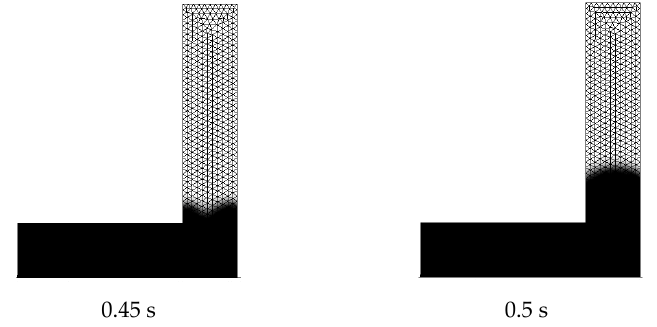
Figure 8. Filling process in the L ‐ shaped mold cavity.